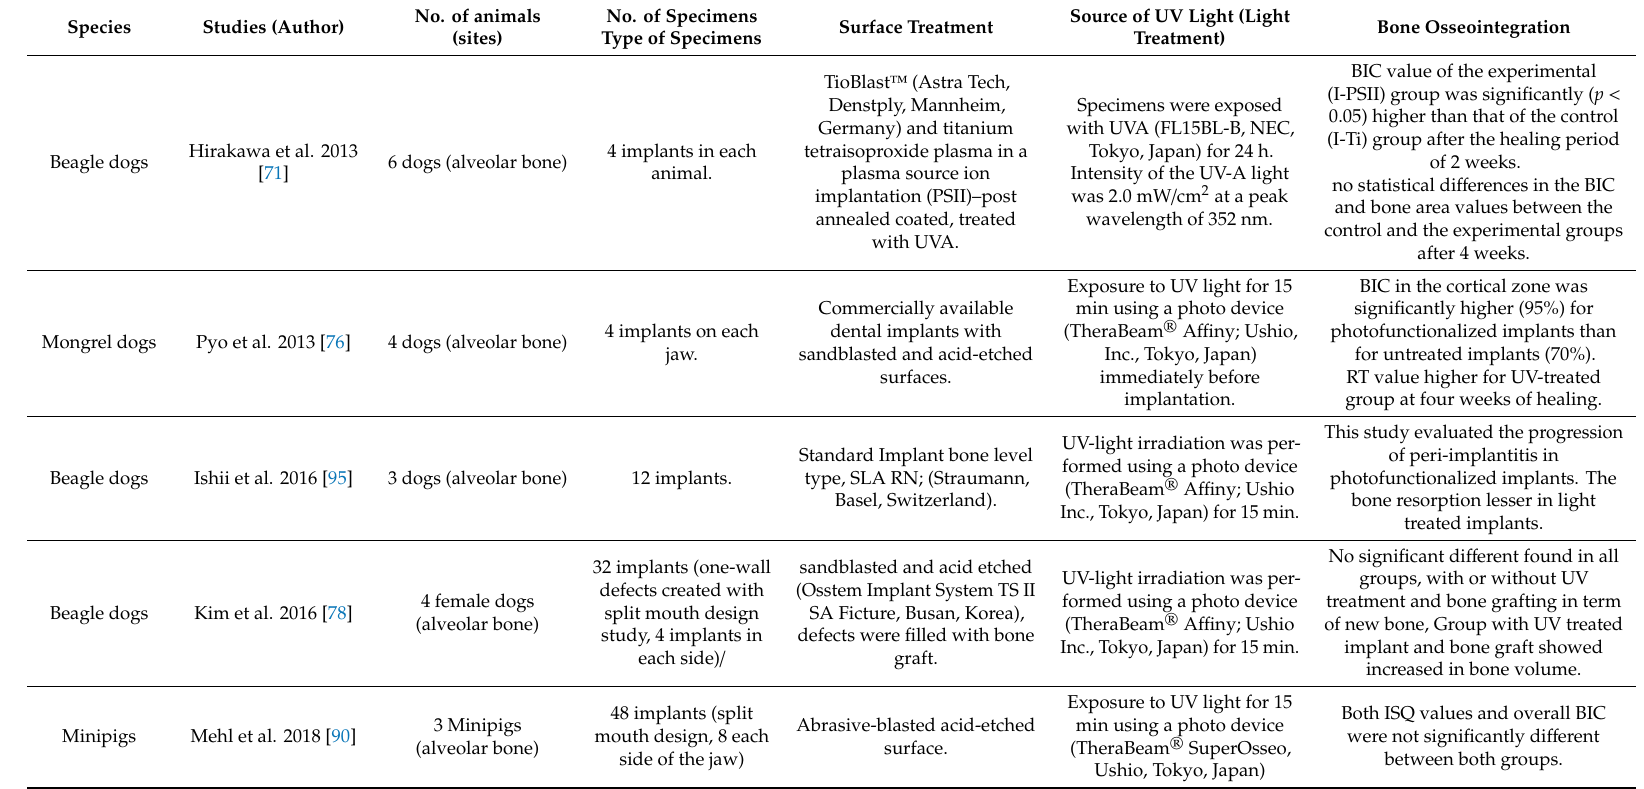
Table 4. E ff ect of UV photofunctionalization on big animal